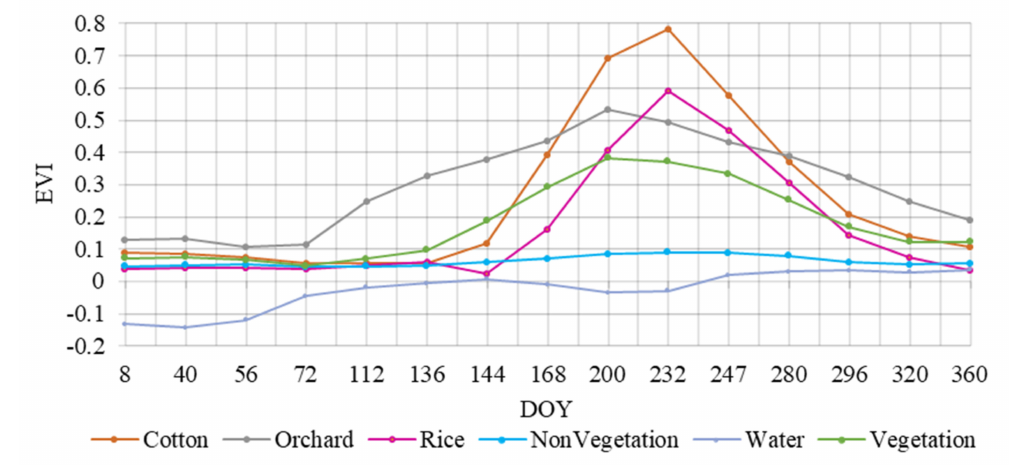
Figure 5. Temporal EVI of different land cover types in